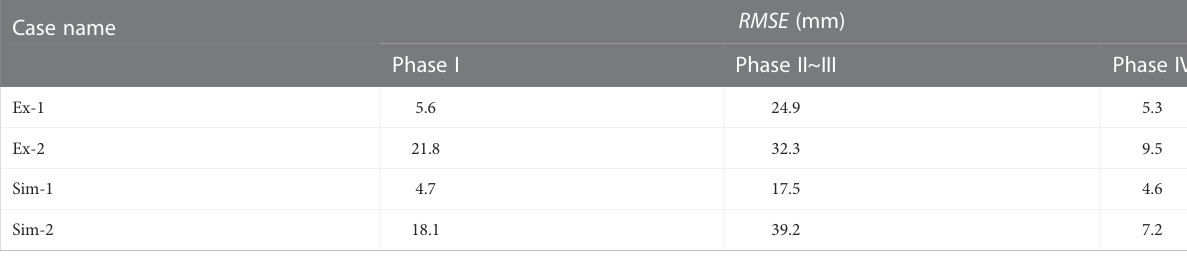
TABLE 2 Root-mean-square error of simulated results under two different deposition